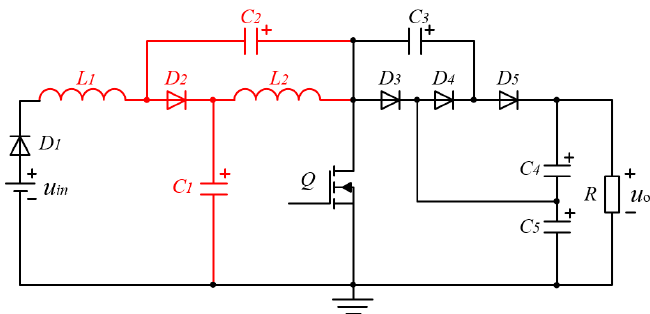
Figure 1. The DC–DC converter topology based on the quasi-Z-source network.